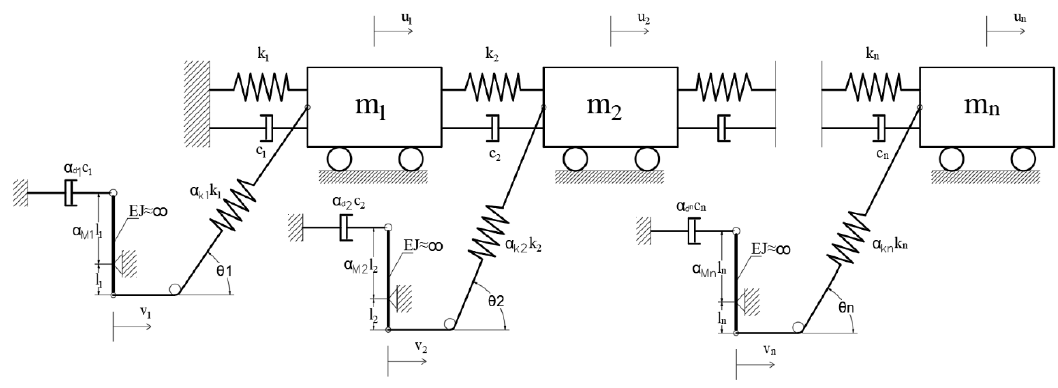
Figure 4. Mechanical model of a MDOF structure equipped with the proposed system.